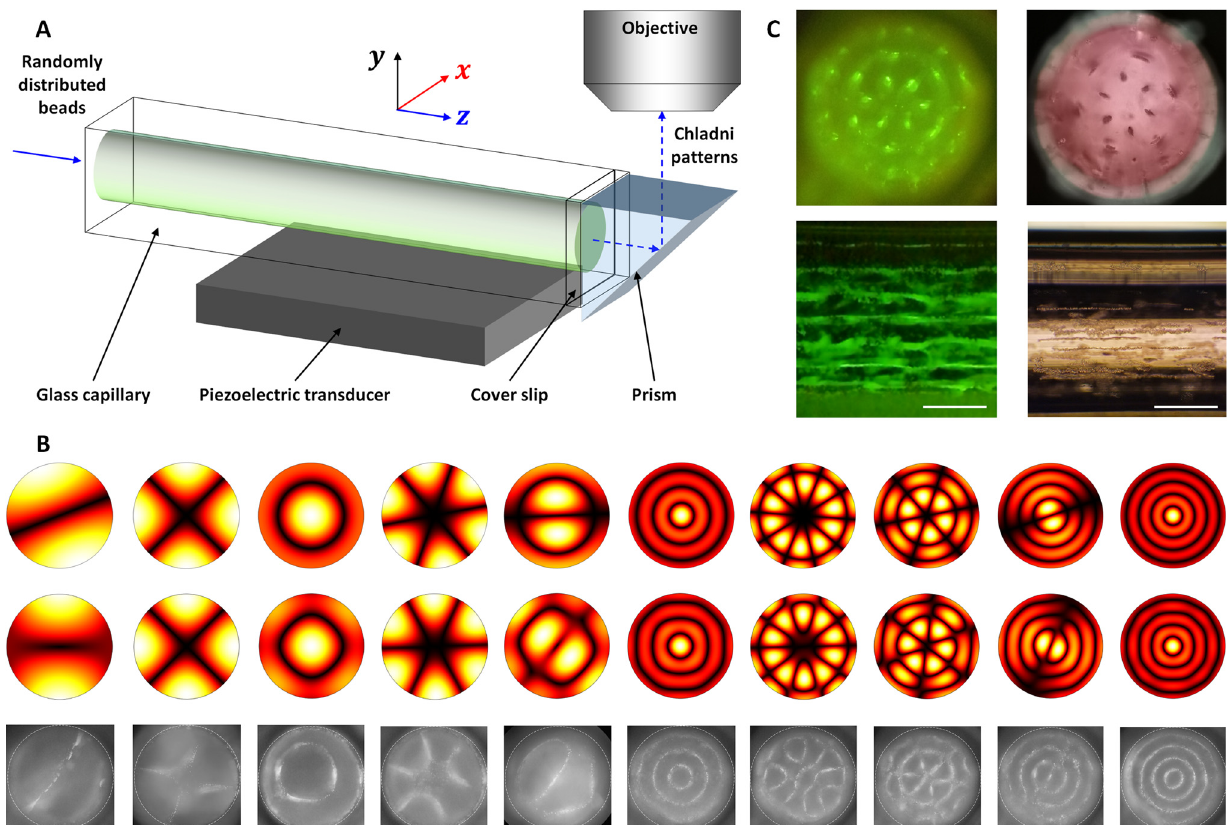
Figure 12. Acoustic microparticle patterning in cross-section of a circular glass capillary ( d = 1.6 mm). ( A ) Schematic of the acoustofluidic device and imaging system. ( B ) The predicted acoustic resonances and the measured patterns of 10 µ m particles in cross-section of the channel. ( C ) Further trapping of 10 μ m polystyrene particles ( left ) and Hela cells ( right ). Reprinted with permission from [77] .